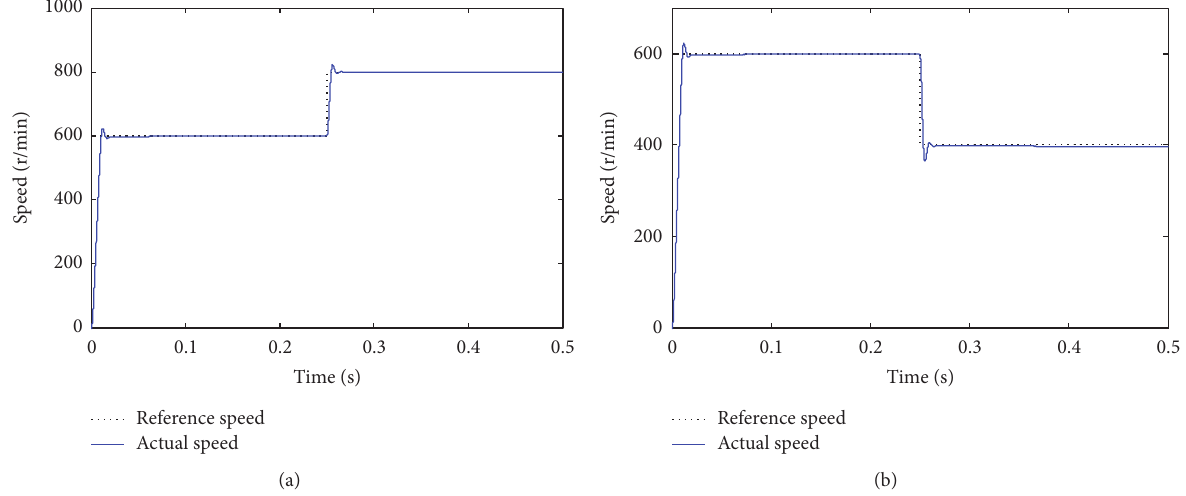
Figure 8: Speed tracking under speed changing. (a) Speed increasing. (b) Speed decreasing.